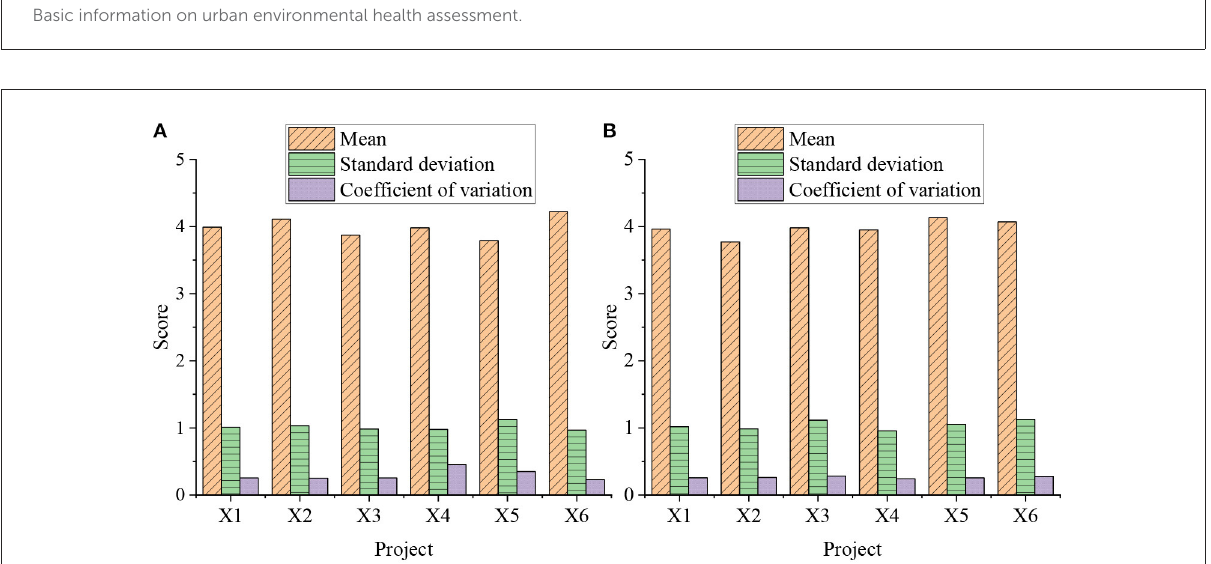
FIGURE3 The specific parameters of the city’s evaluation of each indicator in 2020 and 2021 [ (A) is 2020; (B) is 2021].